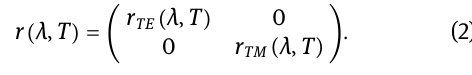
Figure 6: Optical applications of an anisotropic PCMA: modulation of intensity, color, and polarization. (A, B) Heating induced gradual tuning of near-unity absorption spectra of the NB1 sample under illumination of (A) TM- and (B) TE-polarized light, respectively. Anisotropic broadband modulation depth spectra of reflection intensity from the NB1 sample obtained from (C) full-field simulation and (D) experiment. (E) Polarization-dependent gradual multi-level coloring of the NB1 sample described in CIE space. (F) Polarization rotation controlled intermediate color generations with the NB1 sample between TE and TM curves during the heating processes. The insetfiguredepictstop viewschemewhenlinearly polarized lightnormally illuminates thesamplewith rotationangle, θ . (G, H)Thermally switchable R TE / R TM of the NB1 device, at the wavelength of 590 nm derived from (G) simulation and (H) experiment, Commission internationale de l ’ éclairage (CIE) curves ac- cording to polarization direction. Blue to light violet and violet to orange thermal colorings are veri fi ed experimen- tally under illumination of TM and TE polarizations, respectively. Here, re fl ection Jones matrix of a PCMA, r ( λ , T ), can be written as the Eq. (2).